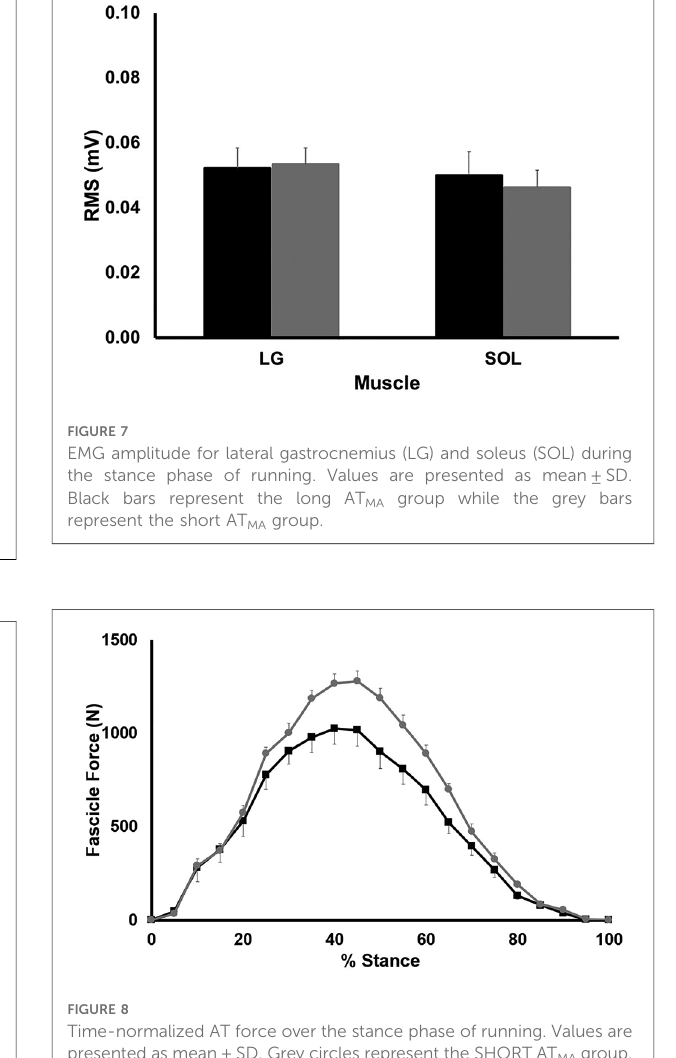
FIGURE 6 Time-normalized fascicle length over the stance phase of running. Values are presented as mean±SD. Grey circles represent the SHORT AT MA group, while black squares represent the LONG AT MA group.